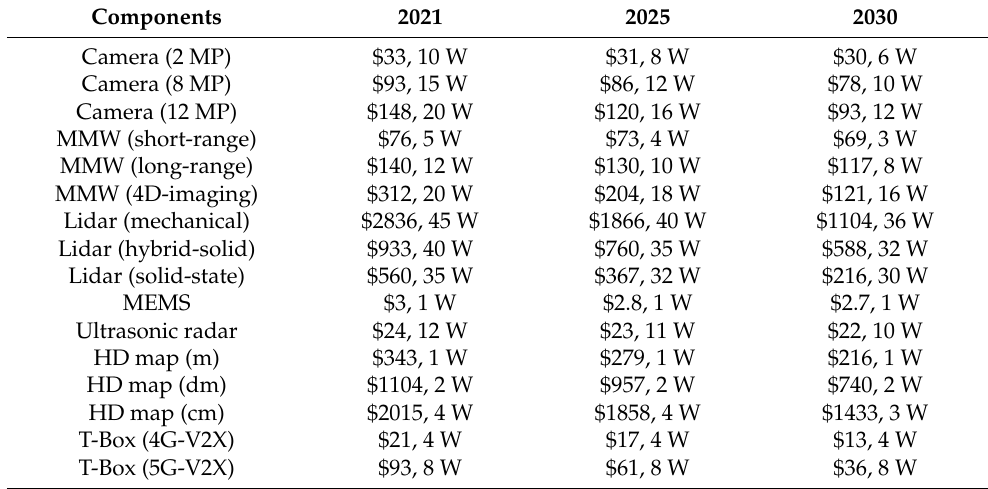
Table 4. Cost and power consumption of various technical components. All costs are shown in